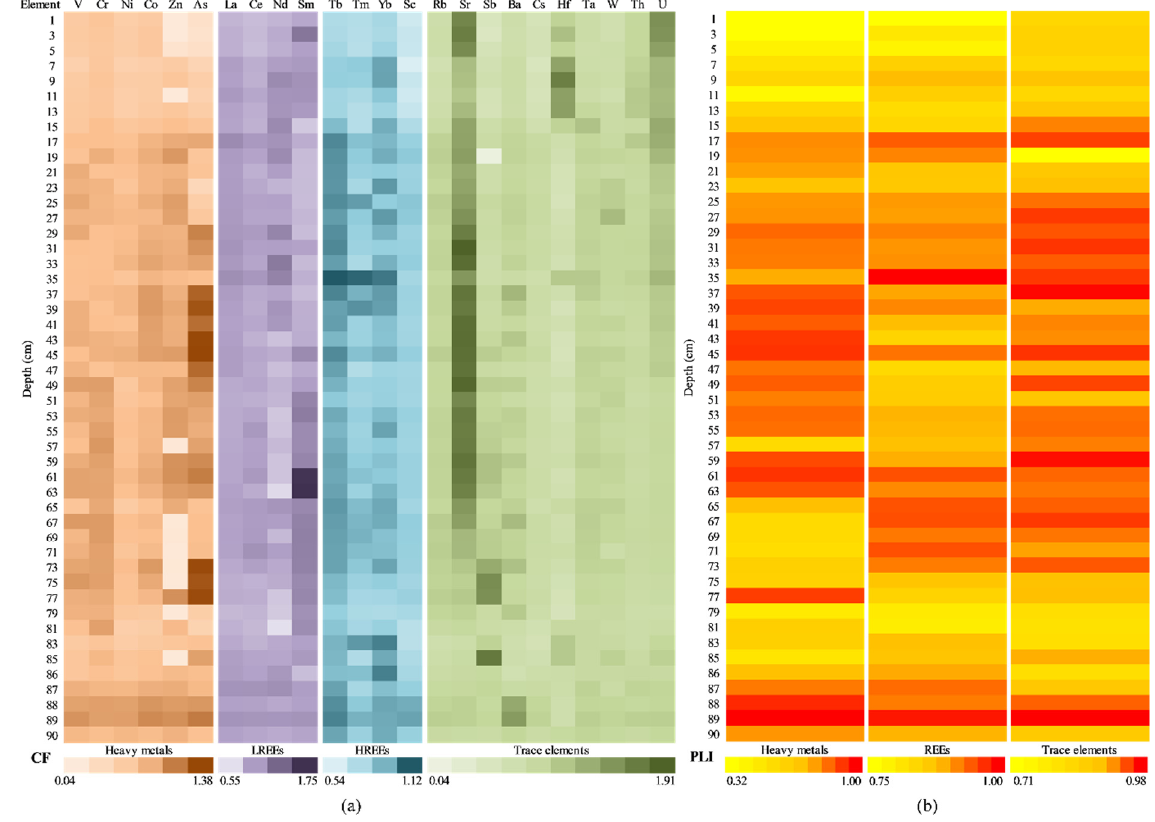
Figure 18. Contamination factors (CFs) ( a ) and pollution load indices (PLIs) ( b ) calculated from the Movila Miresii Lake sediment core (90 cm depth). Movila Miresii Lake sediment core (90 cm